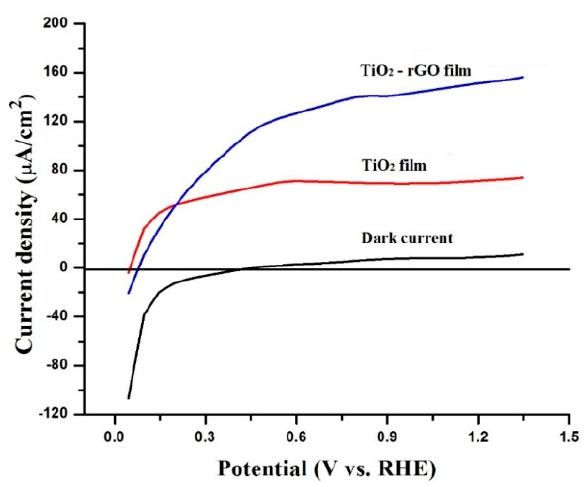
Figure 7. Photocurrent densities of TiO 2 and TiO 2 –rGO films without and with light illumination.